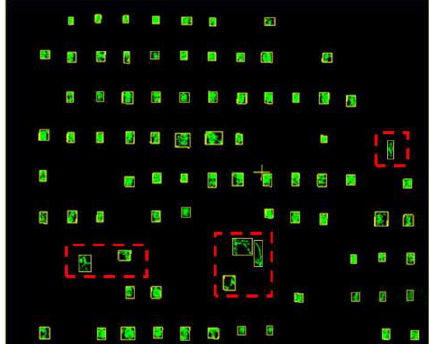
Figure 8. The original classification result of the head of the niche for Buddha